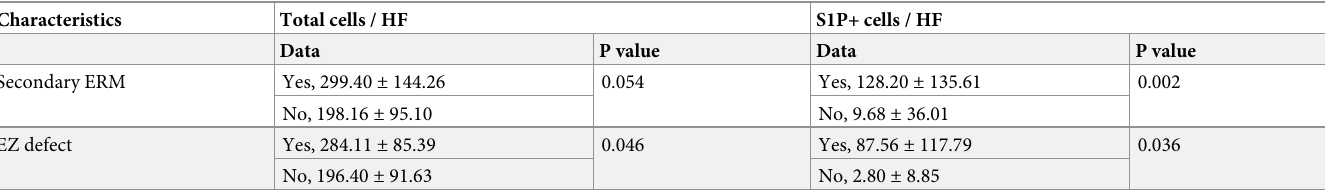
Table 2. Patient characteristics and their association with cellular properties in ERM (n = 24). Characteristics